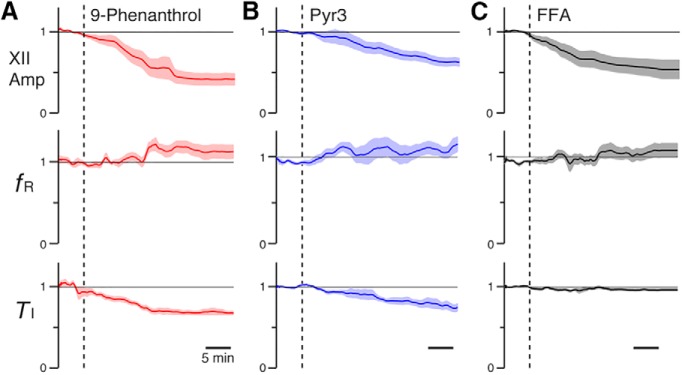
Effects of TRPM4 (A), TRPC3 (B), and ICAN (C) channel inhibitors on rhythmic hypoglossal (XII) activities in neonatal mouse medullary slice preparations in vitro. A–C, Mean time course (solid line) and SEM (light-color band) of the amplitude of normalized integrated XII burst activities (XII Amp), inspiratory frequency (fR), and inspiratory activity time (TI) during drug application (n = 6 slices each). Time of drug administration (A, 50 µm 9-phenanthrol; B, 50 µm Pyr3; C, 50 µm FFA) is indicated by vertical broken lines.